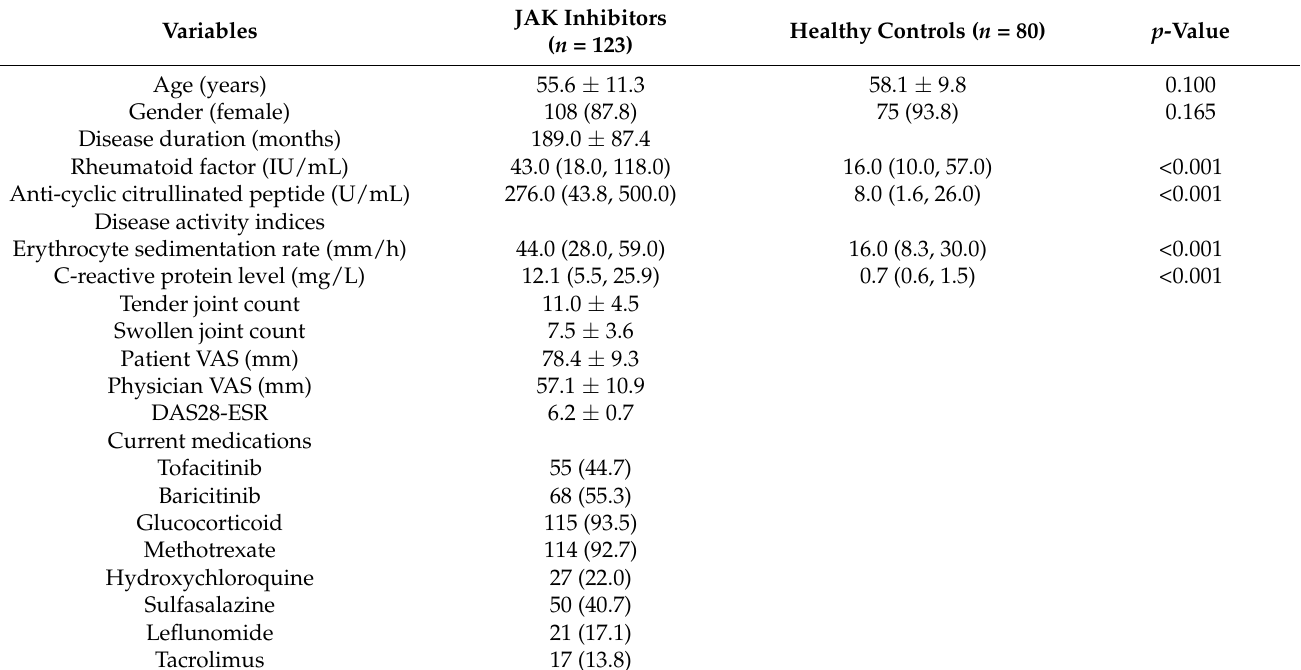
Table 1. Baseline characteristics of the study